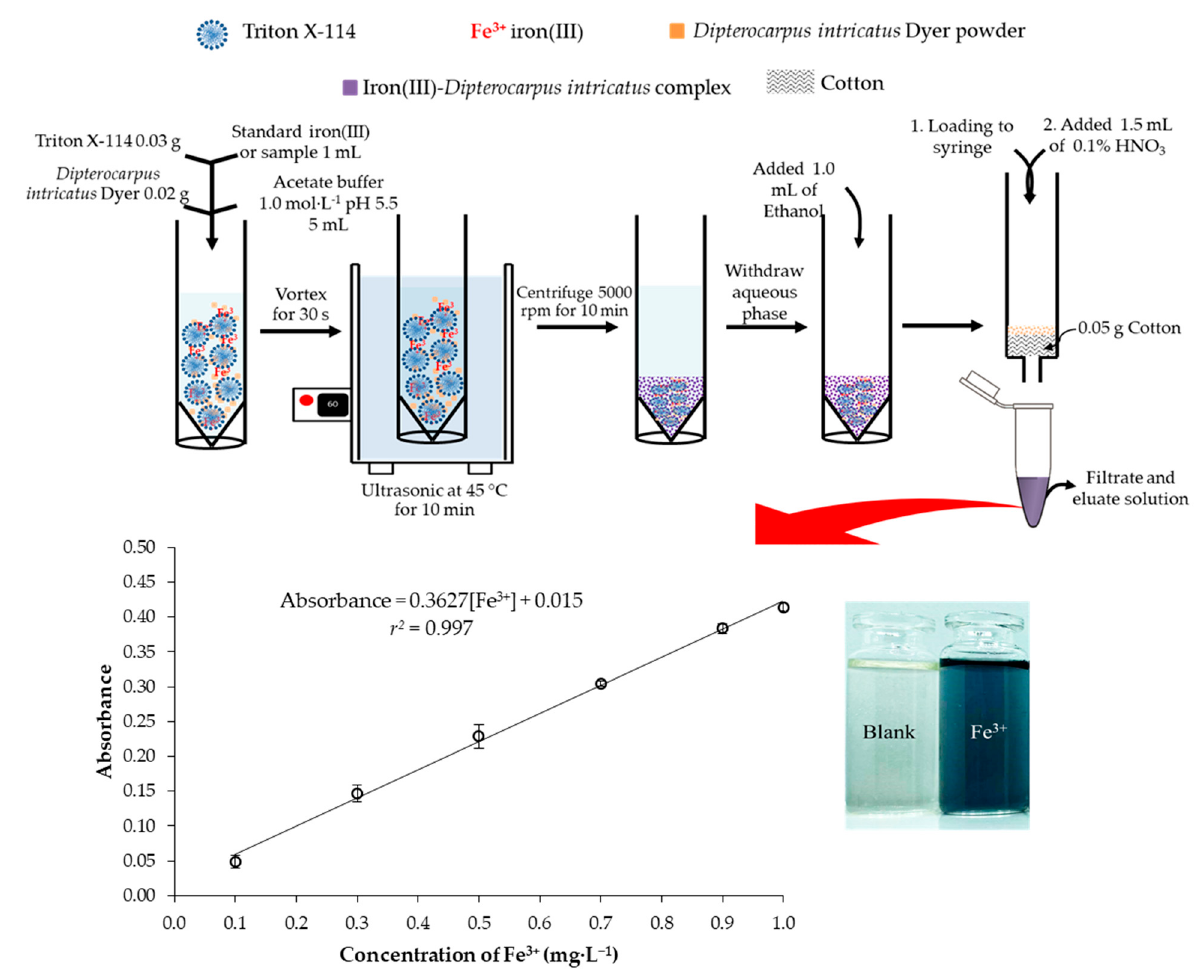
Figure 5. Ultrasound-assisted one-pot operational steps to determine iron by the developed